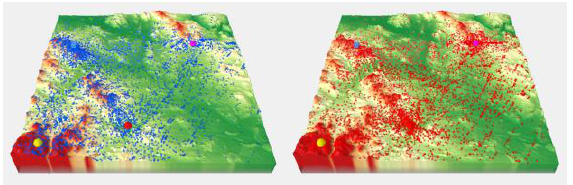
Fig. 7. Comparison of 3D raw data (red points – females, blue points – males) for variant B, task 6.